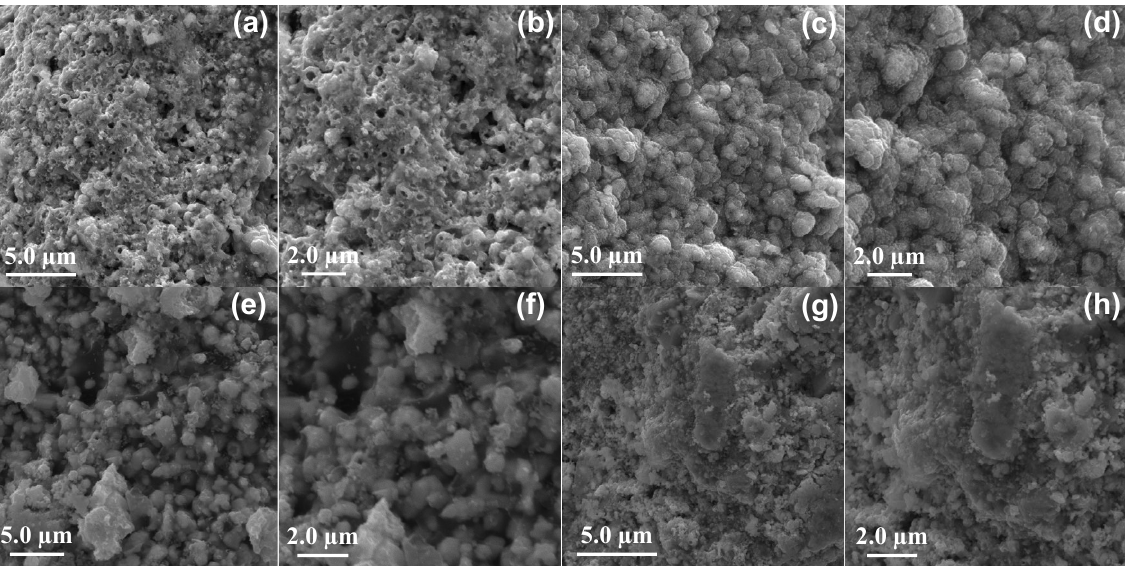
Figure 2. SEM images of the ( a , b ) Ag-C-1, ( c , d ) Ag-C-2, ( e , f ) Ag-C-3, and ( g , h ) Ag-C-4 nanohybrids. The well dispersed Ag-CuO nanohybrids in sample Ag-C-2 were further analyzed with TEM at high resolution. The TEM micrographs and SAED pattern in Figures 3a,b and S1 revealed that at 0.1 g concentration of AgNO 3, the growth of Ag-C-2 was eventually controlled within the range of 20–35 nm. The appearance of strong EDX peaks of Ag, Cu and O have confirmed that as prepared Ag-C-1, Ag-C-2, Ag-C-3 and Ag-C-4 nanohybrids do not contain impurities (Figure S2a–d, respectively) The mapping results reveled the existence of the Ag, Cu, and O in the Ag-CuO nanohybrids (Figure S3).